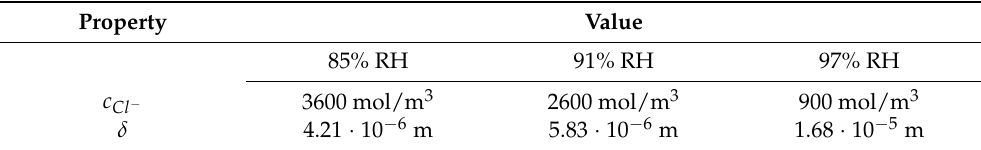
Table 4. Liquid film total chloride concentration and thickness derived from exposure conditions [77,78].